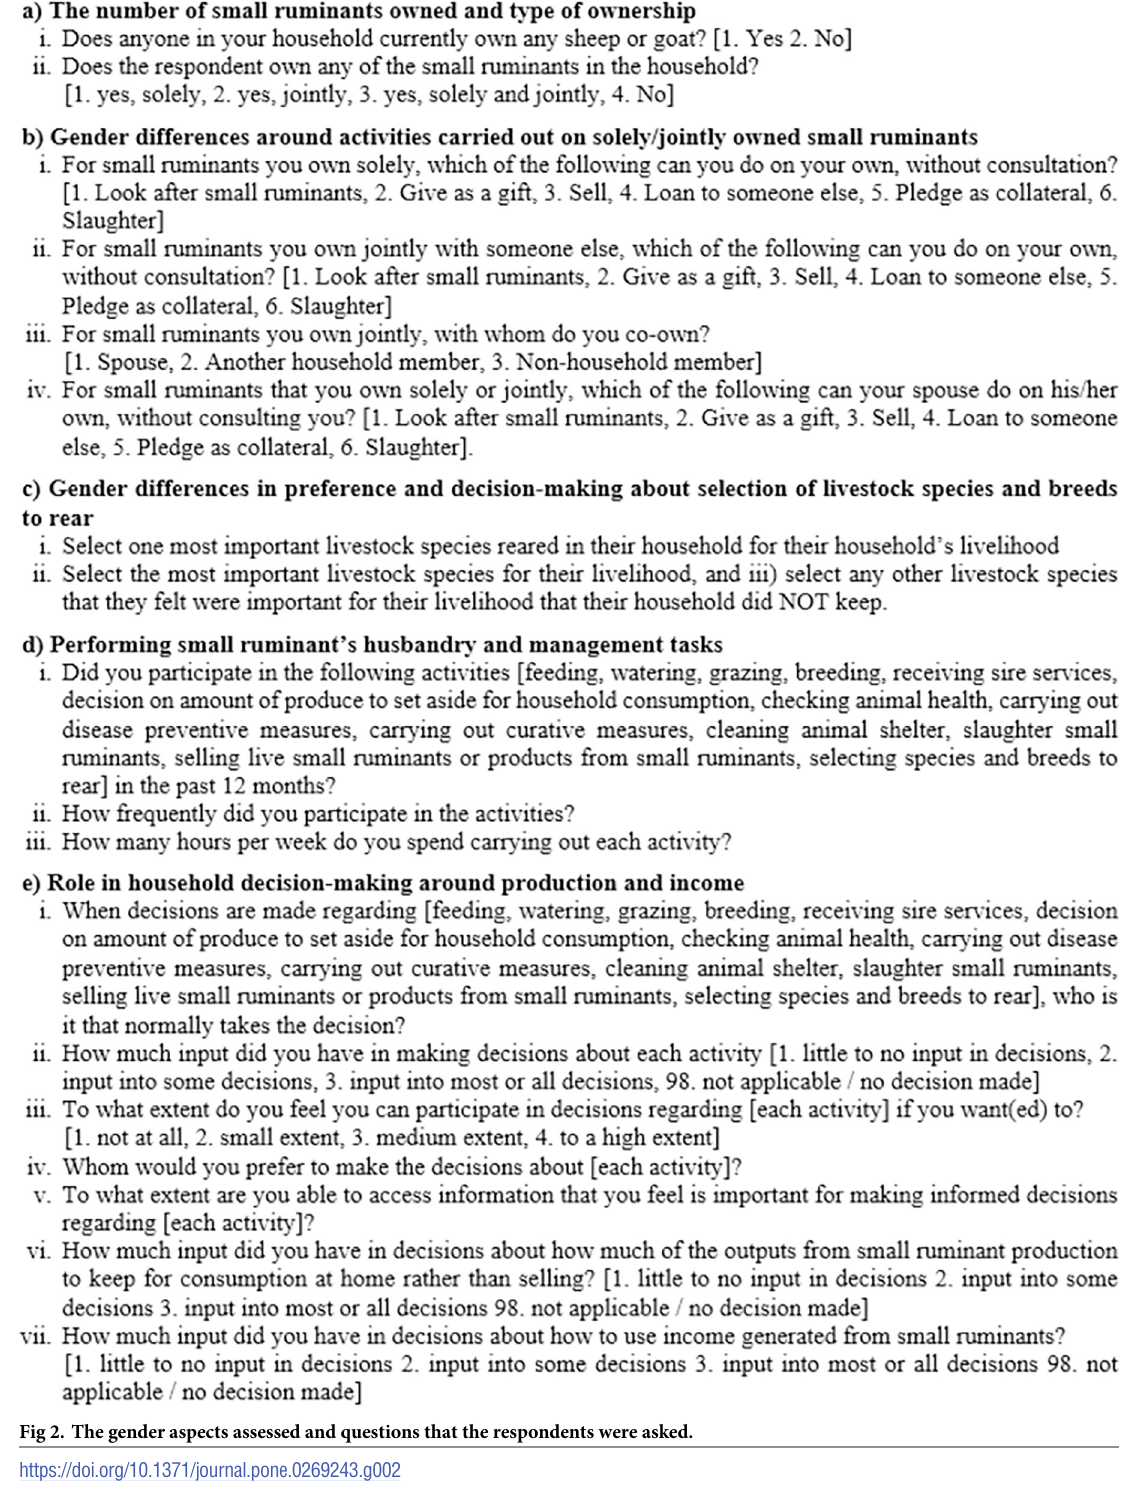
Fig 2. The gender aspects assessed and questions that the respondents were asked.